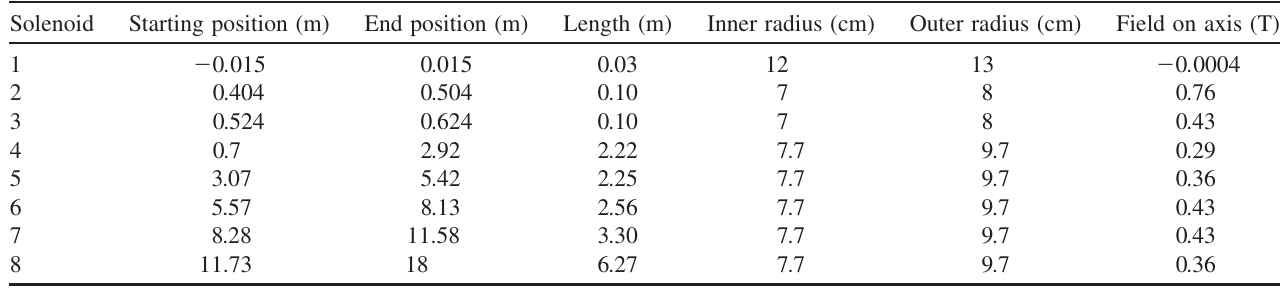
TABLE II. Positions and on-axis field of solenoid.